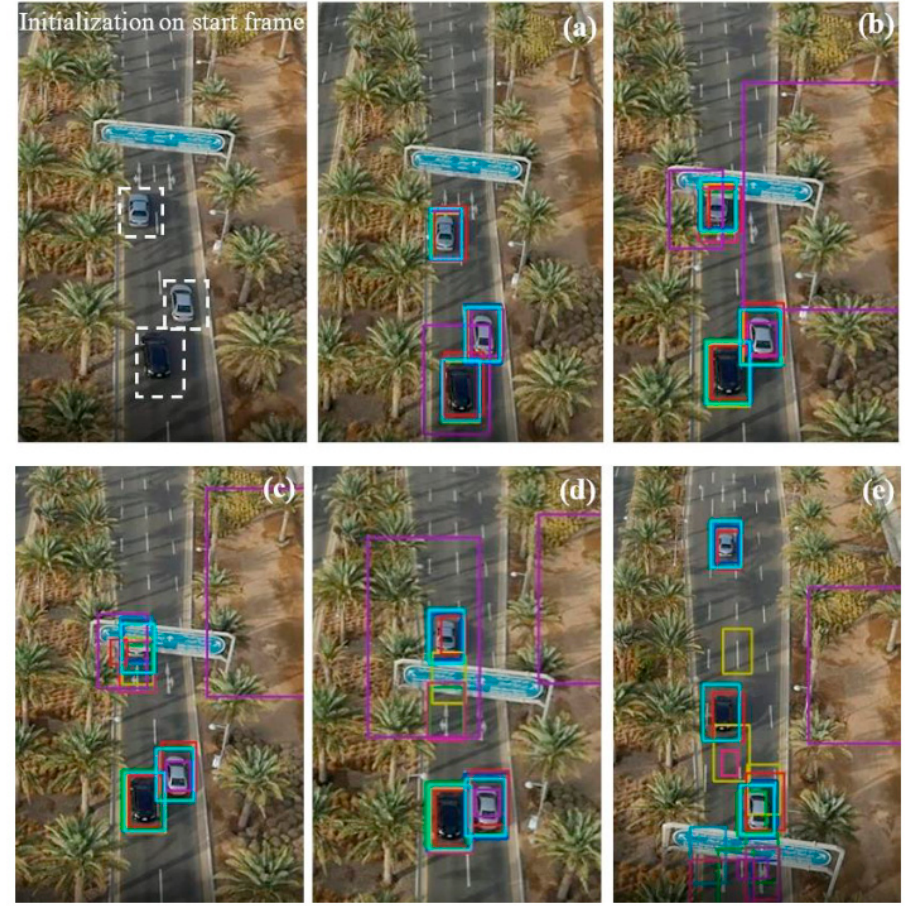
Figure 5. Processed frames as the time goes on (frames ( a – e )) during a multiple car (three objects) tracking process on the UAV123 dataset.